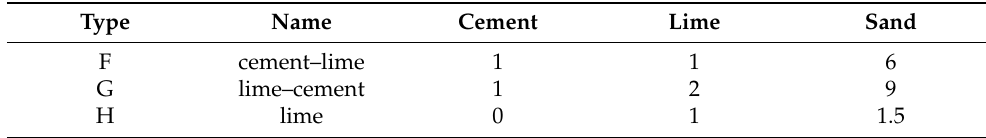
Table 1. Mortar volumetric composition 1 . Binders: CEM I 32,5 R + hydrated